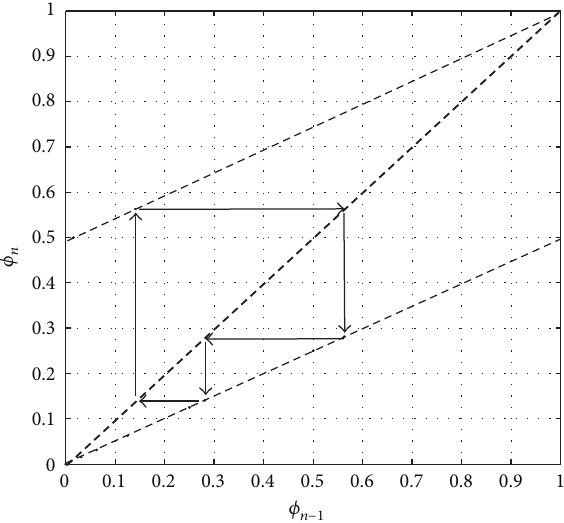
Figure 4: The evolution of characteristic function of the period-3 attractor, where the values of characteristic function of the attractor are 0.2813, 0.1406, and 0.5625,